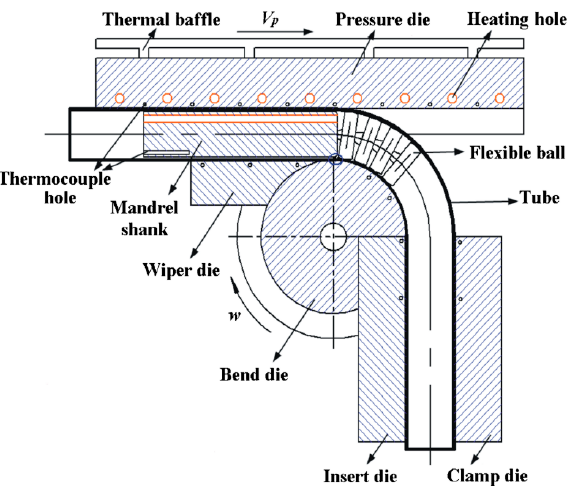
Figure 1. Schematic of local heat-assisted bending of thin-walled titanium tube, adapted with permission from Springer Nature [6].